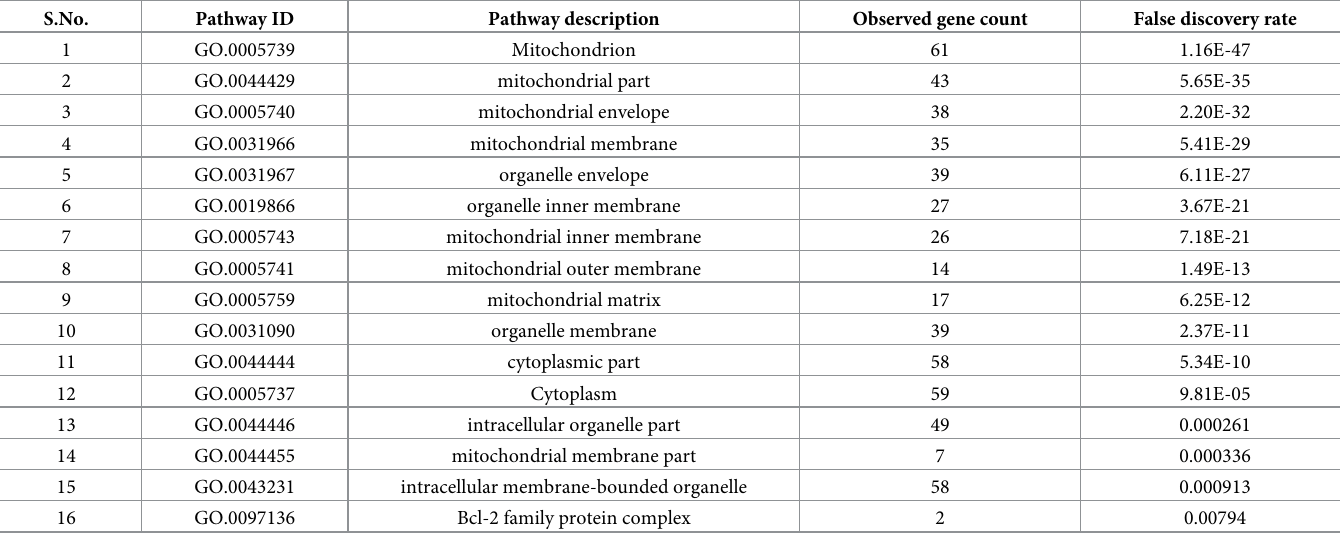
Table 7. The significantly enriched cellular components (CC) of the RA synovial mitochondrial DEGs.